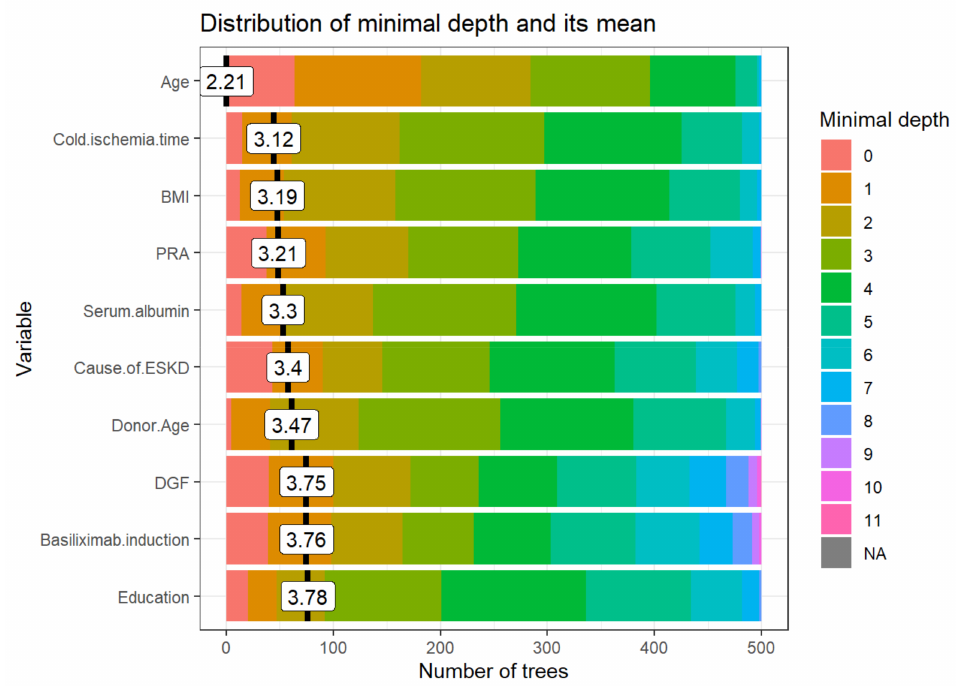
Figure 2. The distribution of the minimal depth among the trees of the forest for the important variables is presented in distinctive colors for the individual level of minimal depth. The mean of the distribution is demonstrated by a vertical black bar with a value label on it, and the scale of the X-axis ranges from 0 to the maximum number of trees in which any variable was utilized for splitting. Abbreviations: BMI- Body mass index; DGF—Delayed graft function; ESKD—End-stage kidney disease; HLA—Human leukocyte antigen; PRA—Panel reactive